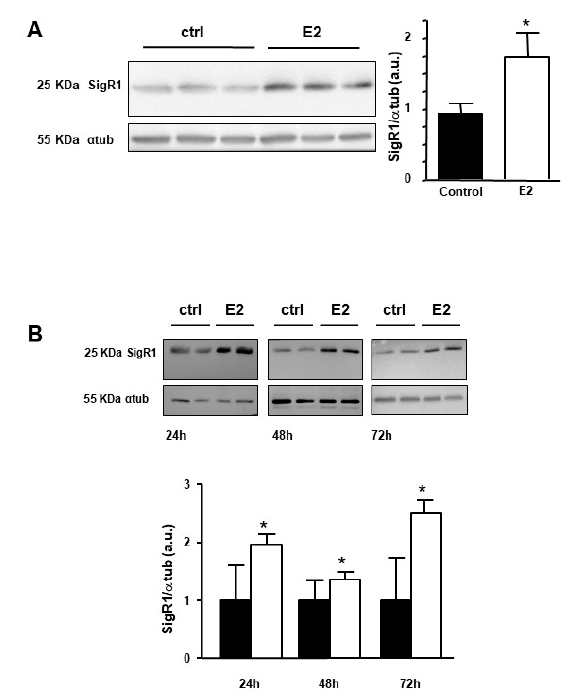
Figure 2. Effect of estrogens on the expression of SigR1. ( A ) Protein expression of SigR1 by western blot and quantification in control mice liver samples (ctrl, solid bars, n = 19) or 24 h after the injection of E2 (E2, empty bars, n = 20), p = 0.03. ( B ) Protein expression of SigR1 by western blot quantification on Huh7 cell lysate in control (ctrl, solid bars, n = 10) and after 24, 48, or 72 h treatment with E2 (empty bars, n = 5). Data are shown as mean SEM, 24 h— p = 0.001, 48 h— p = 0.005, 72 h— p = 0.002. Mann–Whitney U ± test. * p < 0.05, More details of the western bolts, please view at the supplementary